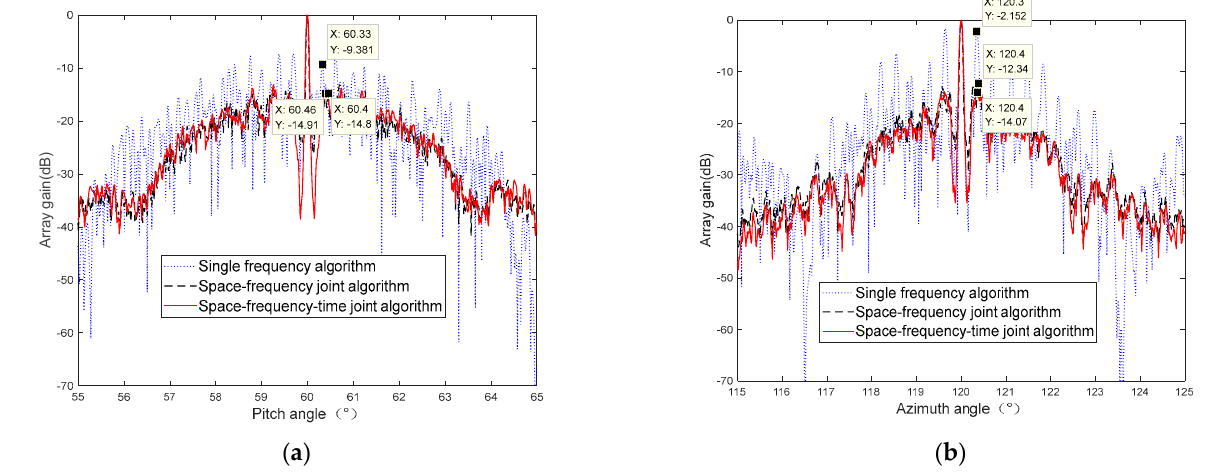
Figure 9. The beampattern under elevation angle of 60 and azimuth angle of 120. ( a ) The elevation pattern; ( b ) the azimuth pattern.